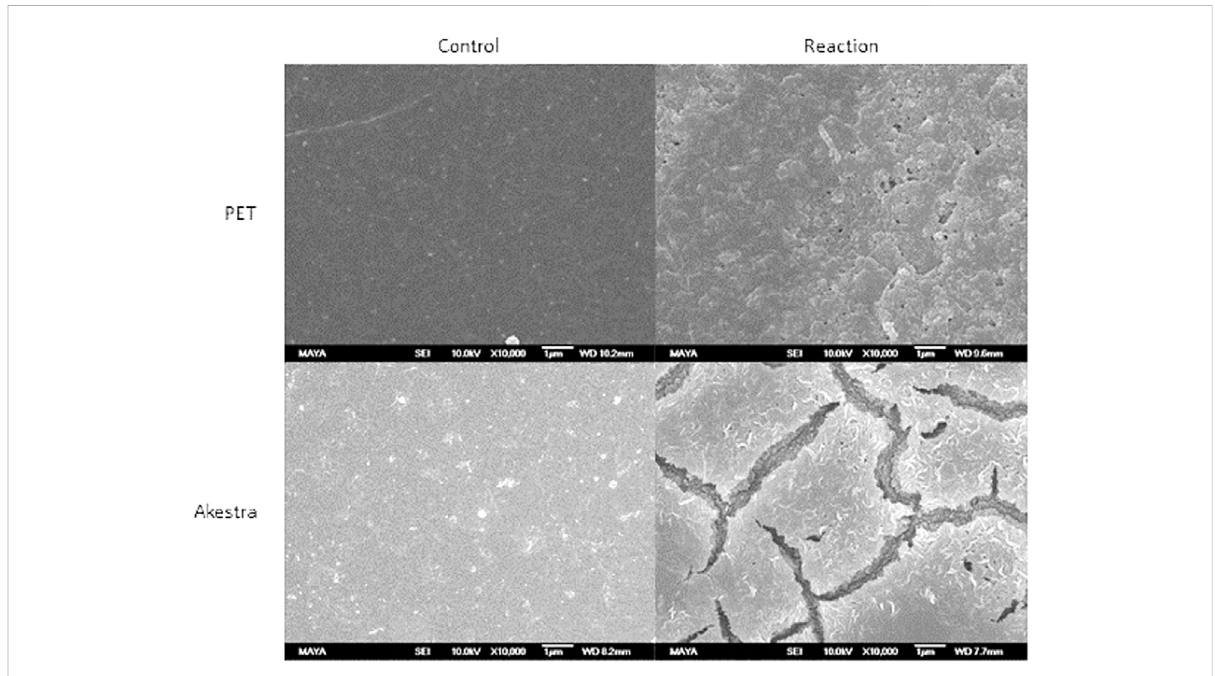
FIGURE 6 SEM images of PET and Akestra TM fi lms after 192 h of reaction with HiCut (X10000). Controls on the left and enzymatically treated samples on the